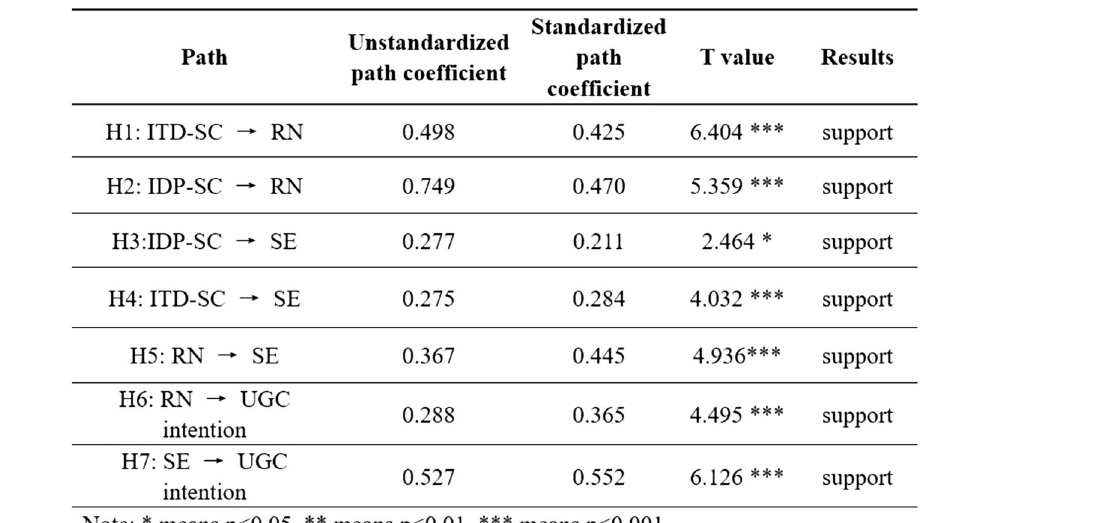
Table 4 Hypothesis test results of the structural equation